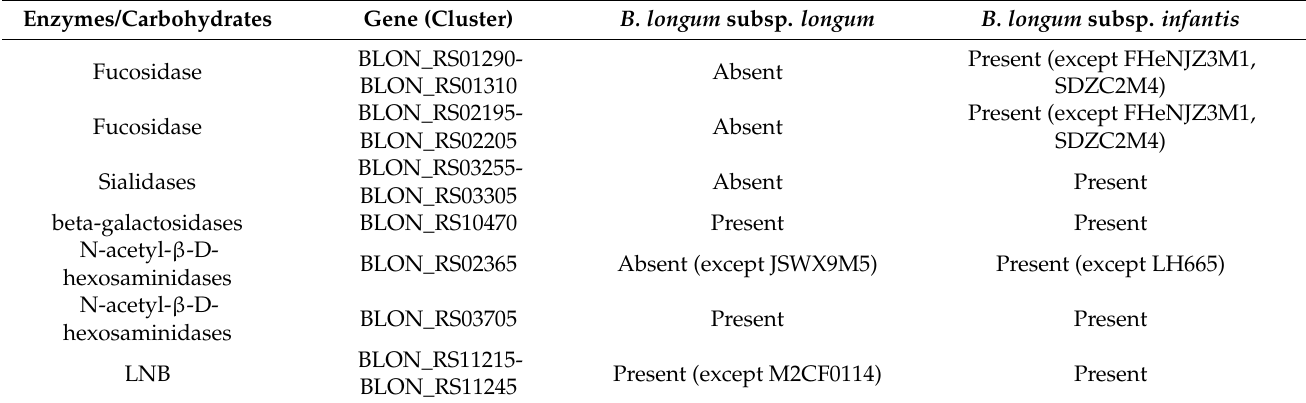
Table 2. Predicted HMOs metabolism-related genes of B. longum .